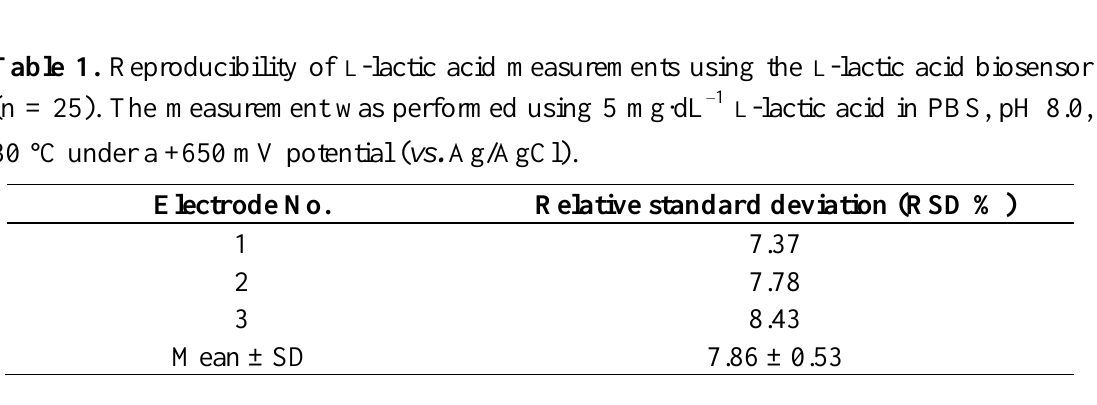
Figure 7. Calibration curves of the biosensor in EISF